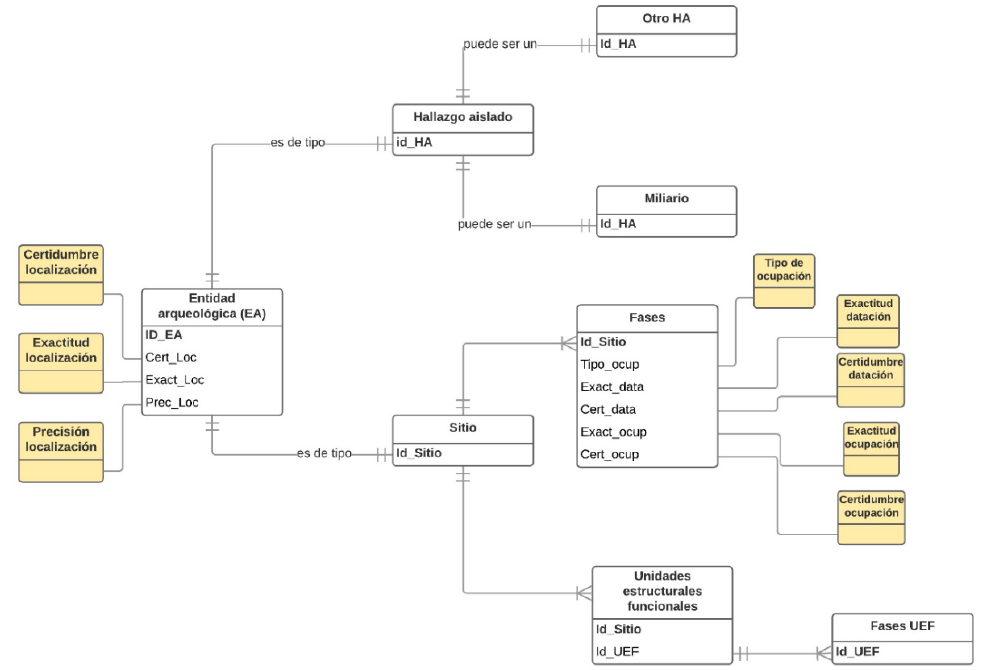
Figure 10. Model (I have simplified the model to make it more intelligible to the reader, without indicating all the fields that make up each of the tables. Including only the information of relevance to better understand the analysis made).